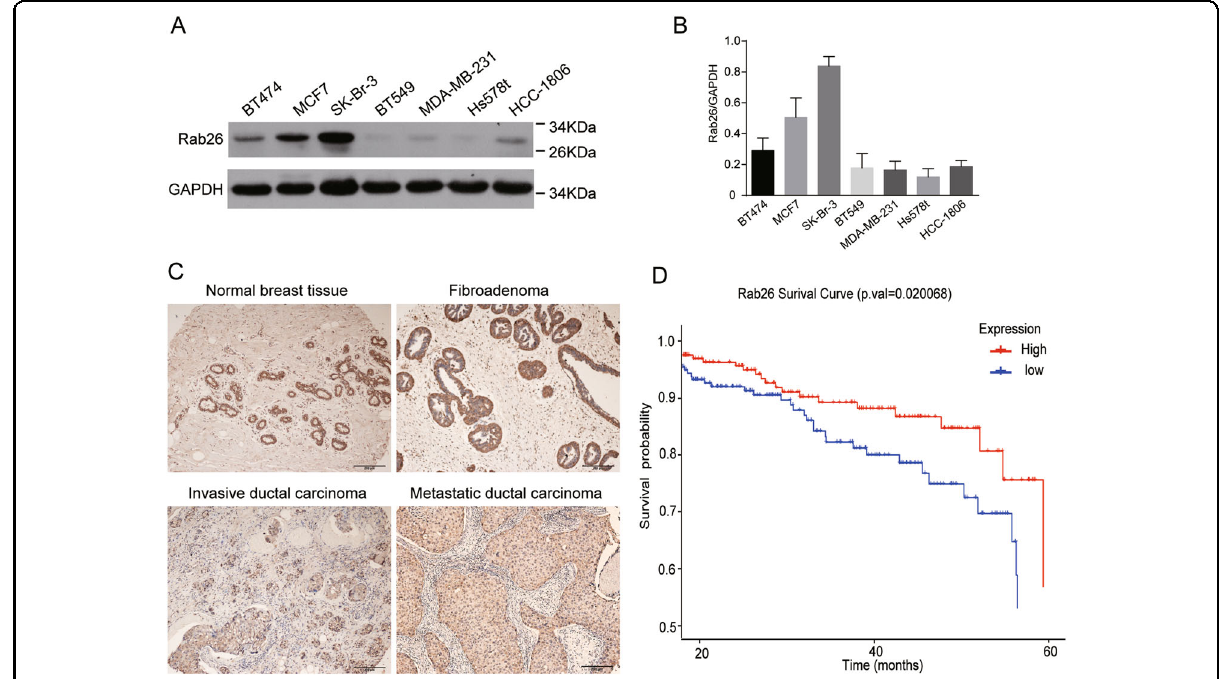
Fig. 1 The expression of Rab26 in breast cancer. A Western-blot experiment demonstrated the protein levels of Rab26 in different breast cancer cell lines. B Quantitative analysis of from three independent experiments described in A , the protein level was normalized to the amount of GAPDH, the results showed Rab26 is highly expressed in non-invasive breast cancer cell lines but suppressed in the invasive breast cancer cell lines. C The representative IHC pictures showed the expression of Rab26 in normal breast tissues, fi broadenoma, invasive ductal carcinoma, and metastatic invasive ductal carcinoma. Bar = 200 μ m. D The clinical signi fi cance of Rab26 expression in overall survivals was evaluated by Kaplan – Meier survival analyses ( n = 985) based on TGCA database, p =